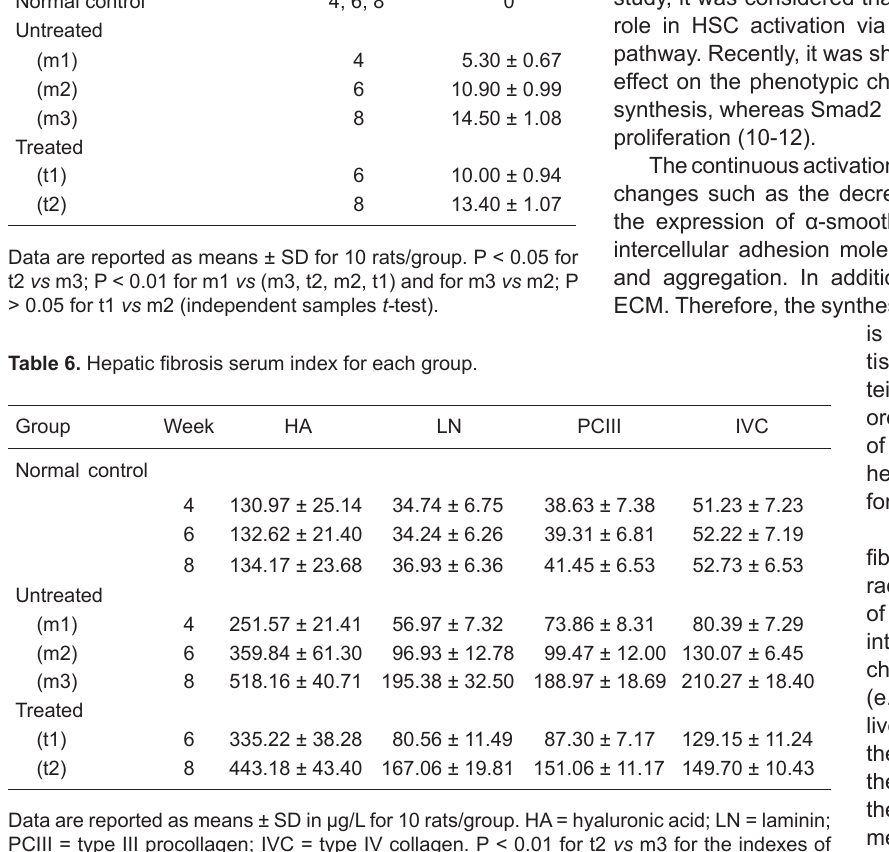
Table 5. Semi-quantitative scoring system (SSS) for hepatic fi- brosis. Group Normal control Untreated